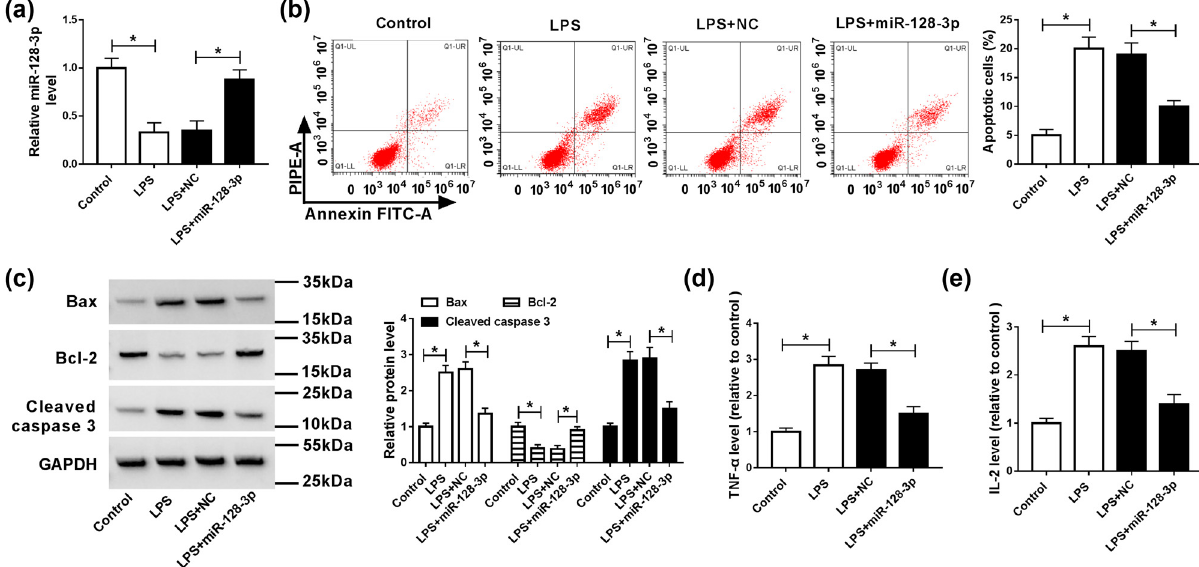
Figure 2: E ff ects of miR - 128 - 3p on apoptosis and in fl ammation in LPS - induced HK2 cells. HK2 cells were treated with LPS or/and transfected with miR - 128 - 3p. ( a ) The expression level of miR - 128 - 3p was measured by qPCR. ( b ) Cell apoptosis was detected by fl ow cytometry. ( c ) The protein levels of Bax, Bcl - 2, and cleaved caspase 3 were analyzed by western blot. ( d and e ) The production pro - in fl ammatory cytokines ( TNF - α and IL - 2 ) was detected by ELISA kit. * P < 0.05.